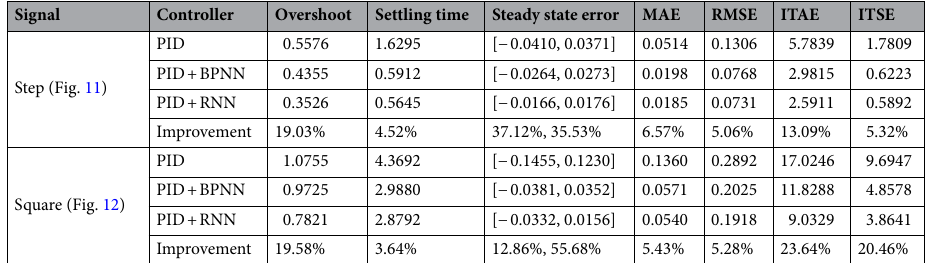
Table 6. Comparisons of experiment results of tracking step and square